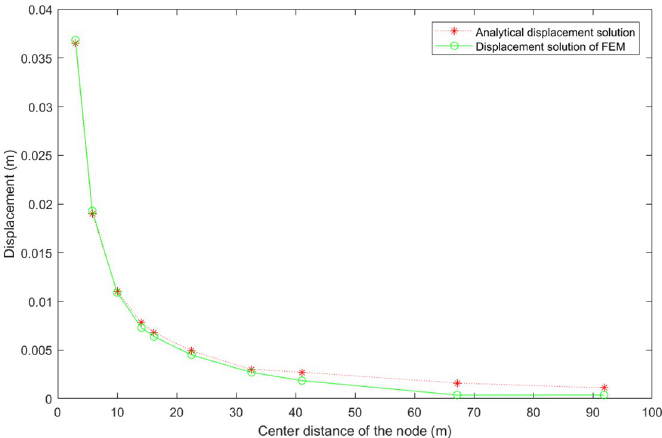
Fig 6. Analytical solution and classical FEM numeric solution-comparison of displacement results.